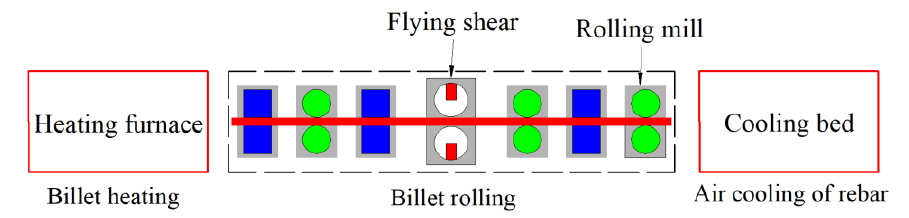
Figure 2. Rolling process for the 55#/316L rebar. Table 3. Rolling parameters for the 55#/316L rebar.